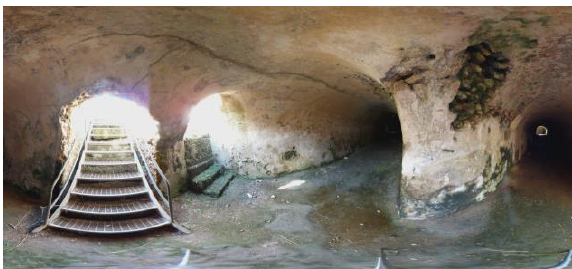
Figure 7. Equirectangular image the Cryptoporticus